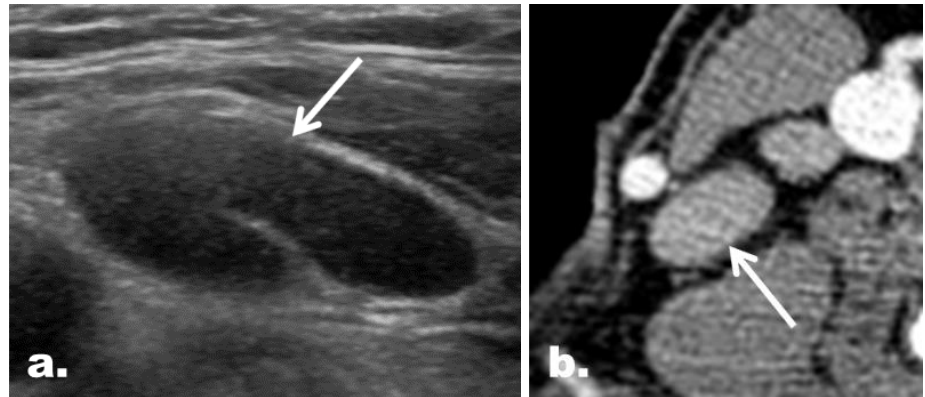
Figure 5. Discordant benign case with the final diagnosis of a benign LN in a 67-year-old woman with PTC. ( a ) On US, an ovoid LN (arrow) with echogenic hilum was found at the right neck level IV. The LN was classified as probably benign LN on US. ( b ) On CT, the LN (arrow) was classified as an